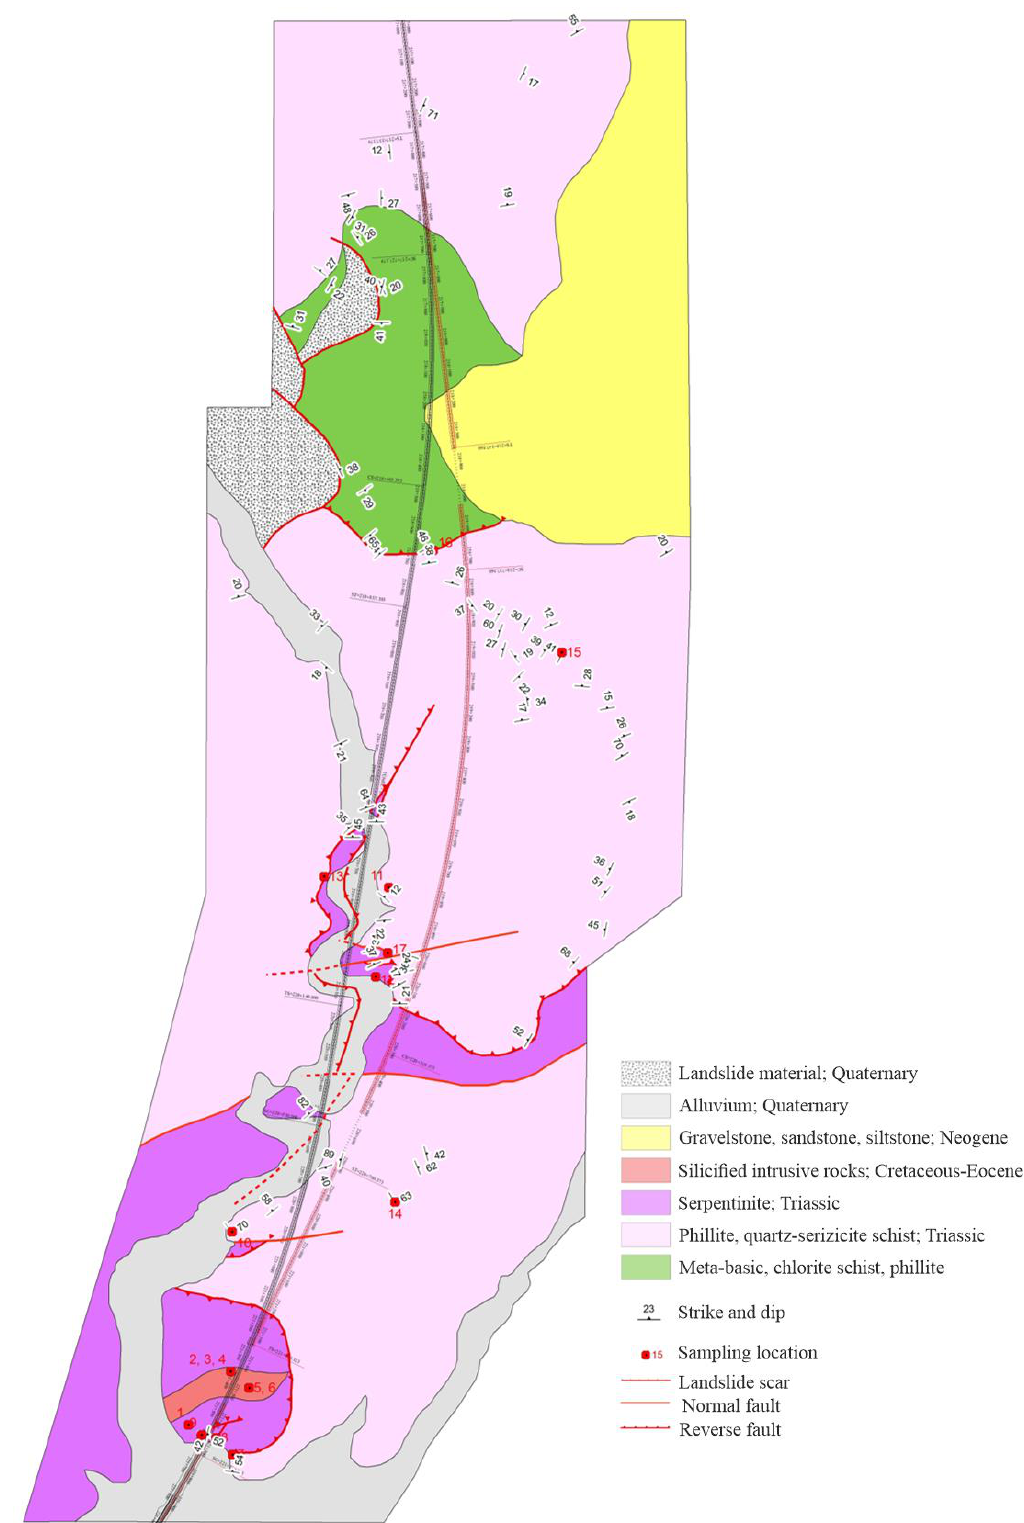
Figure 3. Geological map of the site vicinity; the primary design route is indicated using the purple line [22].